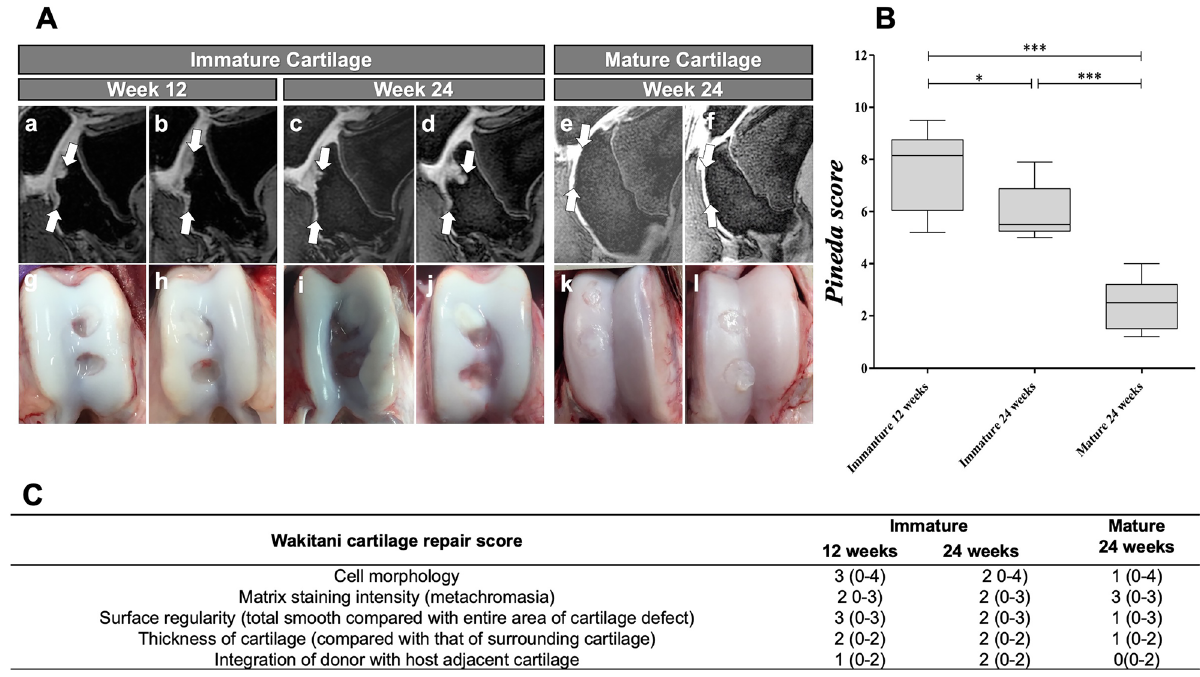
Figure 2. Longitudinal evaluations of cartilage defects in immature and mature cartilage. ( A ) Sagittal SPGR 3D FS knee MRI and macroscopic evaluation of cartilage defects in immature and mature joints at different time points after MASI. (a,b) MRI of two representative immature knee joints at 12 weeks after MASI demonstrates persistent cartilage defect which extends into the subchondral bone. (c,d) MRI of immature knee joints at 24 weeks after MASI demonstrates further increased cartilage and subchondral bone defects. (e,f) By comparison, a cartilage defect in a mature joint has been almost completely repaired at 24 weeks after MASI. There is no subchondral edema or defect. (g,h) Macroscopic specimen of the immature knee joints demonstrated incomplete cartilage defect repair at 12 weeks and increasing defects in the cartilage and (i,j) subchondral bone at 24 weeks. (k,l) By comparison, macroscopic specimens of the mature knee joints demonstrated complete cartilage defect repair at 24 weeks. ( B ) Corresponding Pineda cartilage score of cartilage repair in immature (after 12 and 24 weeks) and mature joints (after 24 weeks). Data are displayed as means and standard deviation of four cartilage defects per group. The Pineda score of cartilage defects of immature joints at 24 weeks was significantly higher compared to the Pineda score of mature joints. ( C ) Corresponding cartilage repair score of immature and mature pigs according to Wakitani cartilage repair scoring system (*p < 0.05, **p < 0.01, ***p < 0.001).